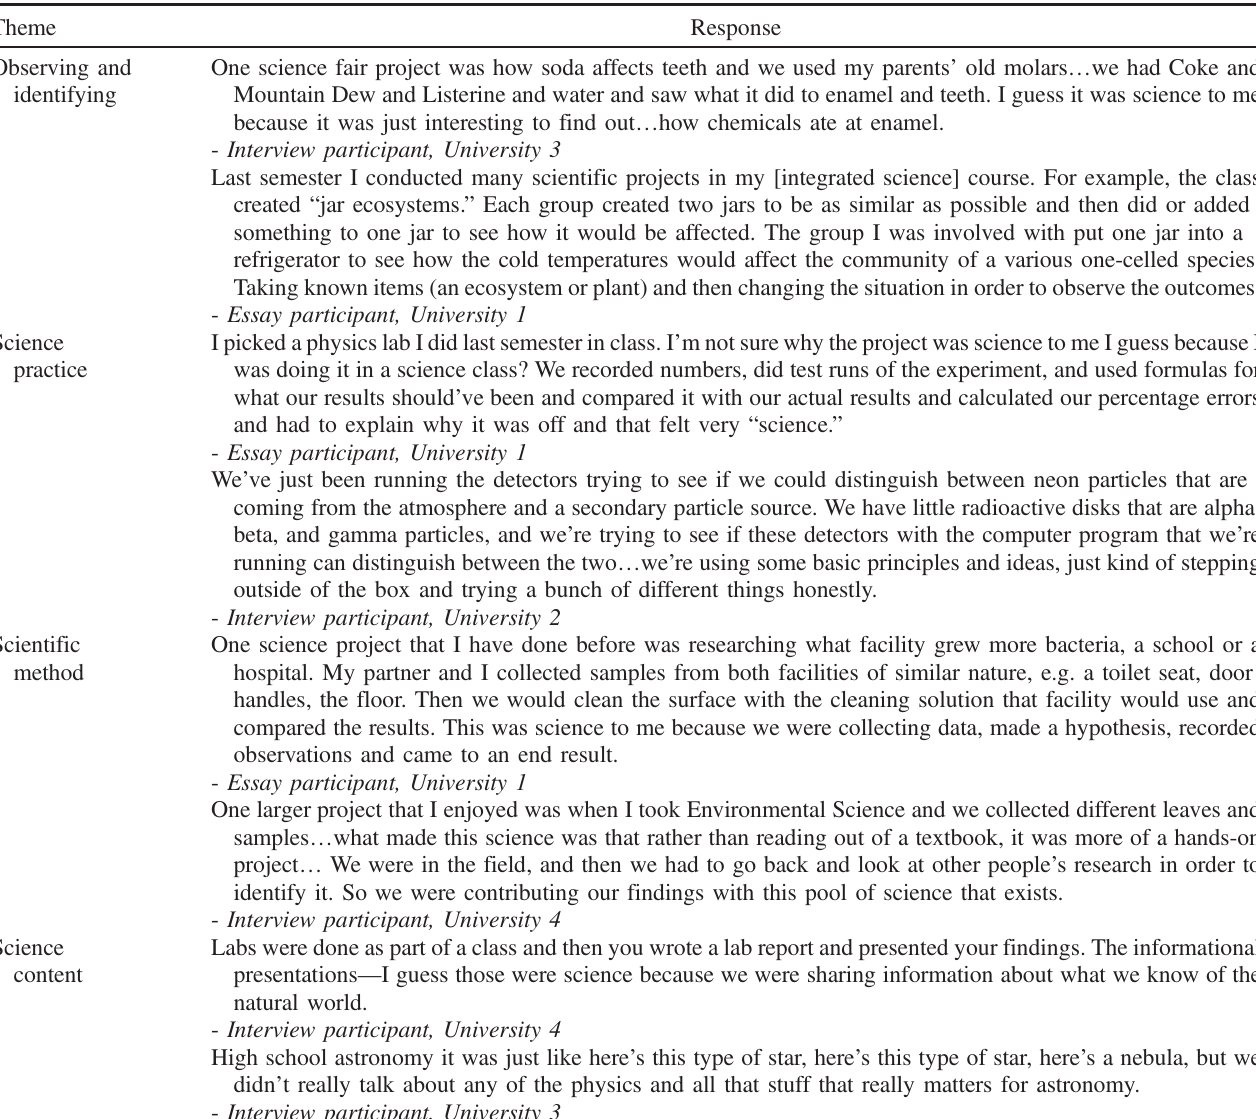
TABLE IV. Example quotes expressing four themes from qualitative analysis regarding students ’ previous science learning